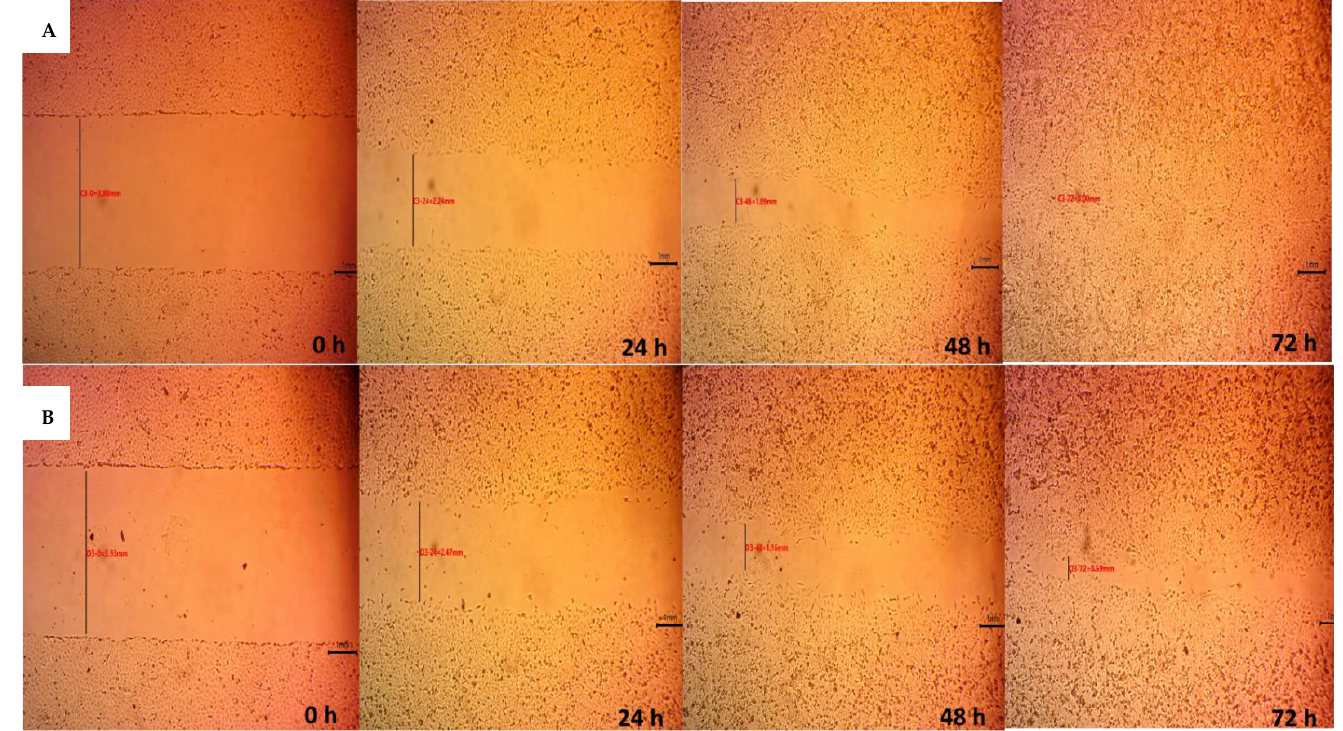
Figure 8. Cell migration test for control group and composite alginate/nano-hydroxyapatite aerogel loaded with tranexamic acid over 72 h.